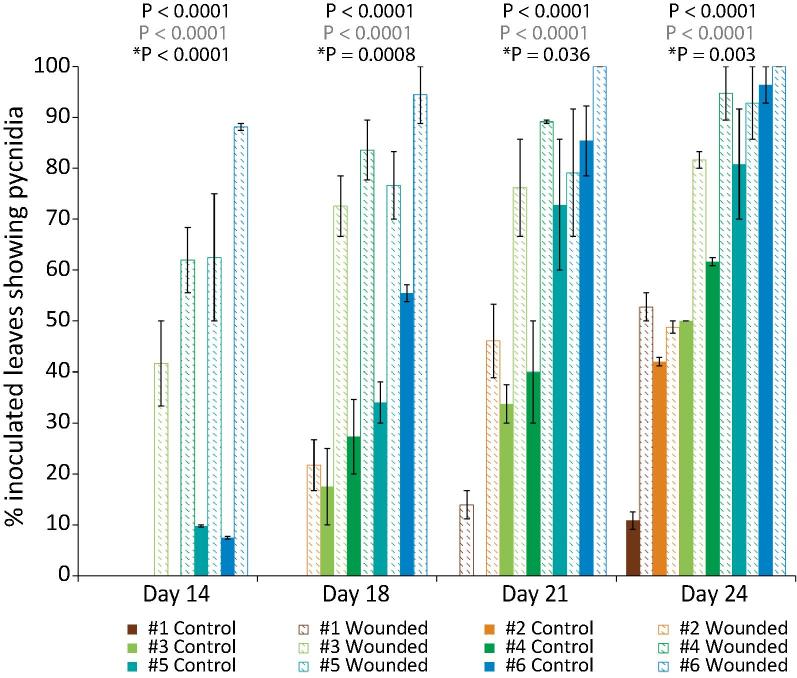
Effect of wounding of host leaves on pycnidiation by Z. tritici IPO323 under six humidity regimes. Leaves were gently abraded prior to inoculation with 106 cfu/ml suspensions of Z. tritici. Control leaves were inoculated, but not abraded. Plants were then maintained under six different humidity regimes (#1 – lowest; #6 – highest). Inoculated leaves were examined from 14 dpi onwards, and the percentage of inoculated leaves bearing pycnidia determined on each day. Data are means of two independent experiments; error bars show SE. Within each time point, two-way ANOVAs were carried out. In each case, humidity, wounding, and the interaction between these treatments were all significant predictors of pycnidiation (P-values above graphs; black text = humidity, grey text = wounding, * = interaction term).